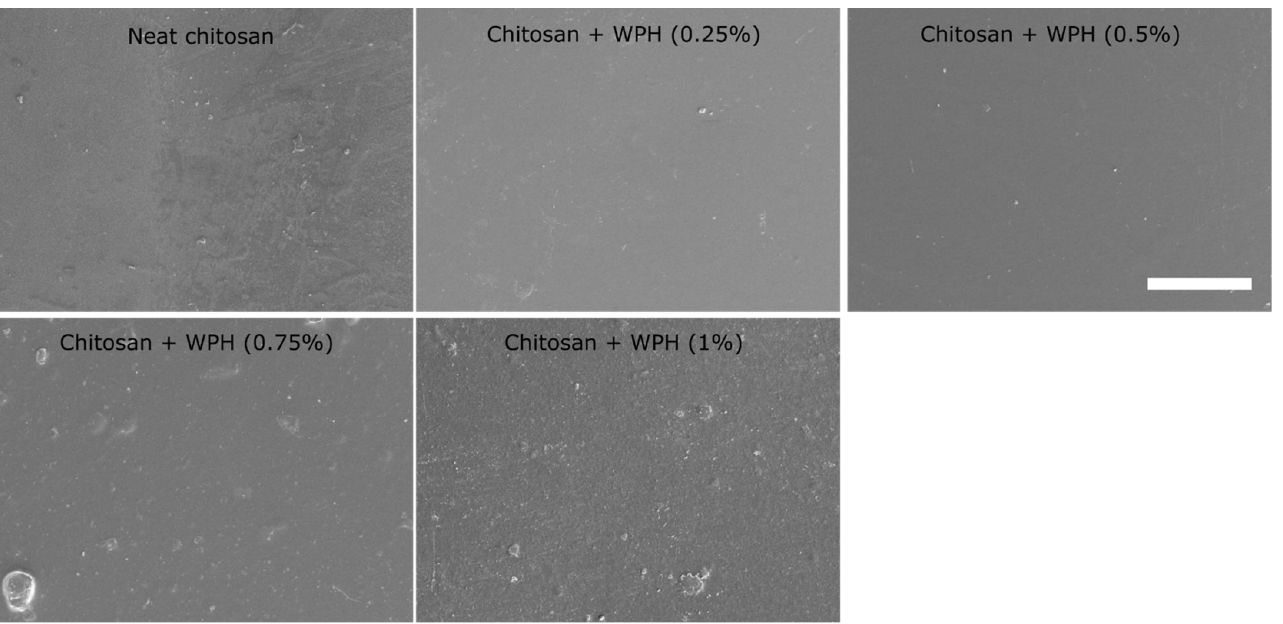
Figure 6. SEM images of chitosan/WPH films containing different concentrations of WPH. Scale bar = 100 μ m.